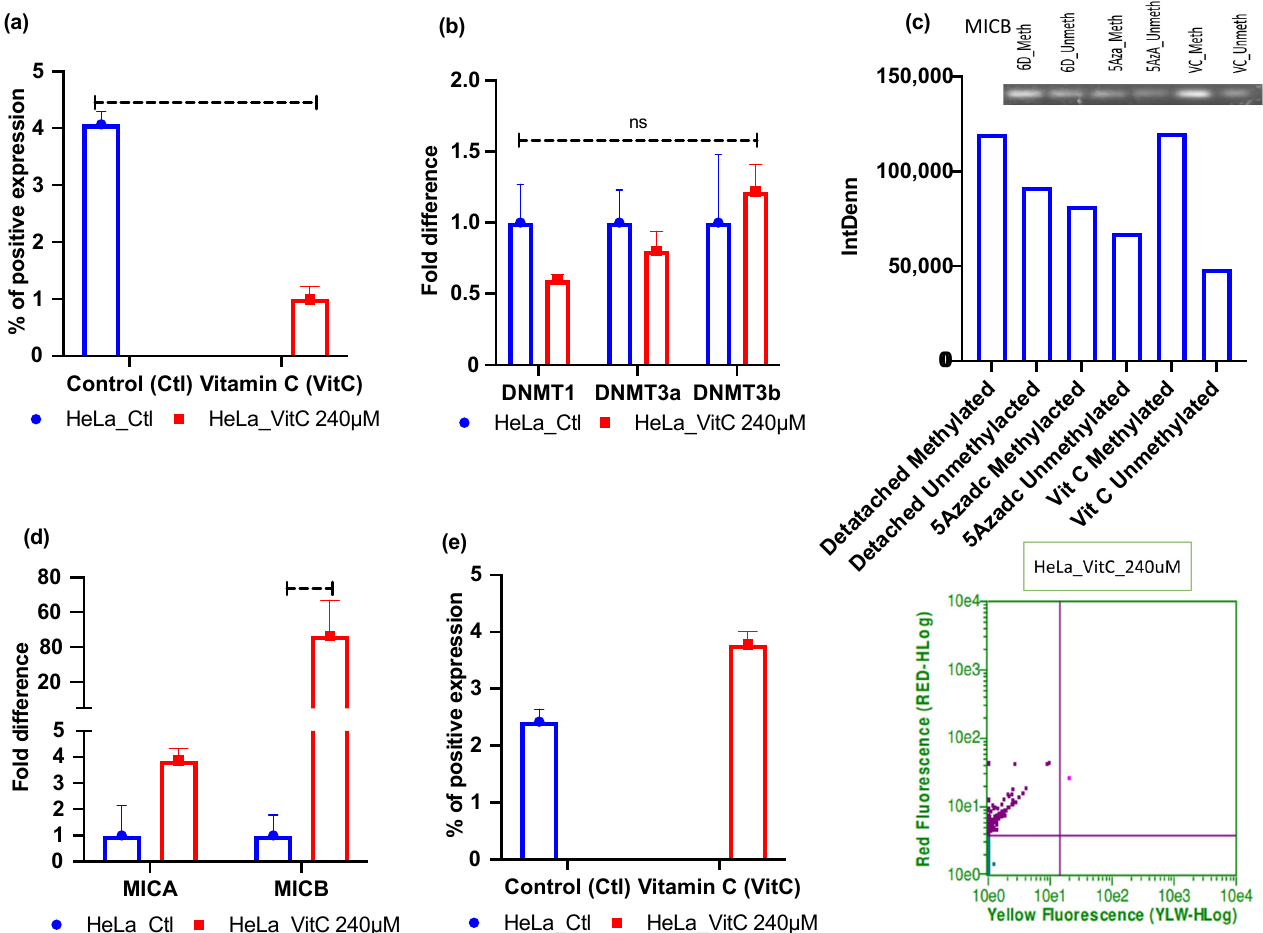
Figure 4. Vitamin C treatment mediated reductions in global DNA methylation, DNA methyl- transferase ( DNMT1/3a ), and induction of MICA/B expression in ECM-detached HeLa cell lines. ( a ) Vitamin C treatment reduced 5mC levels. ( b ) Vitamin C treatment repressed DNMT1/3a